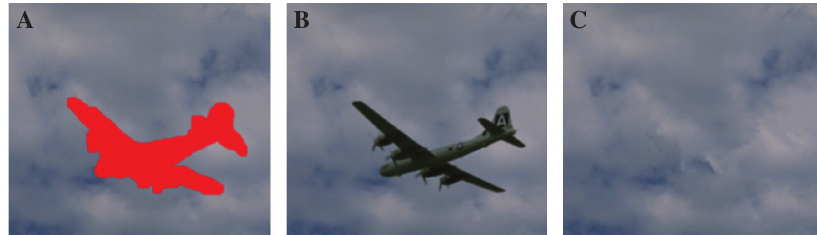
Figure 14. Large Object Removal in Photograph: Patch Size 9 × 9.